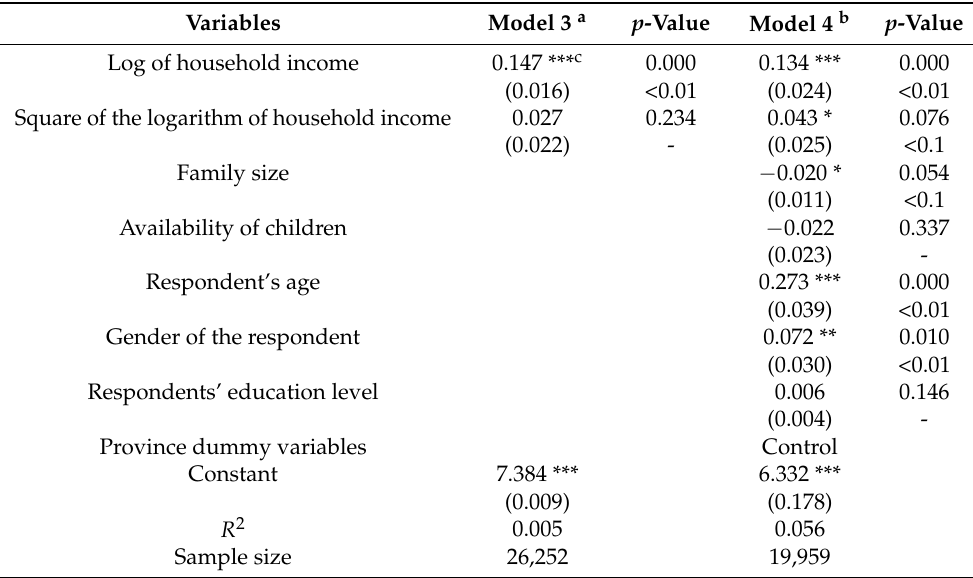
Table 3. Effect of household income on consumption of sugary-free